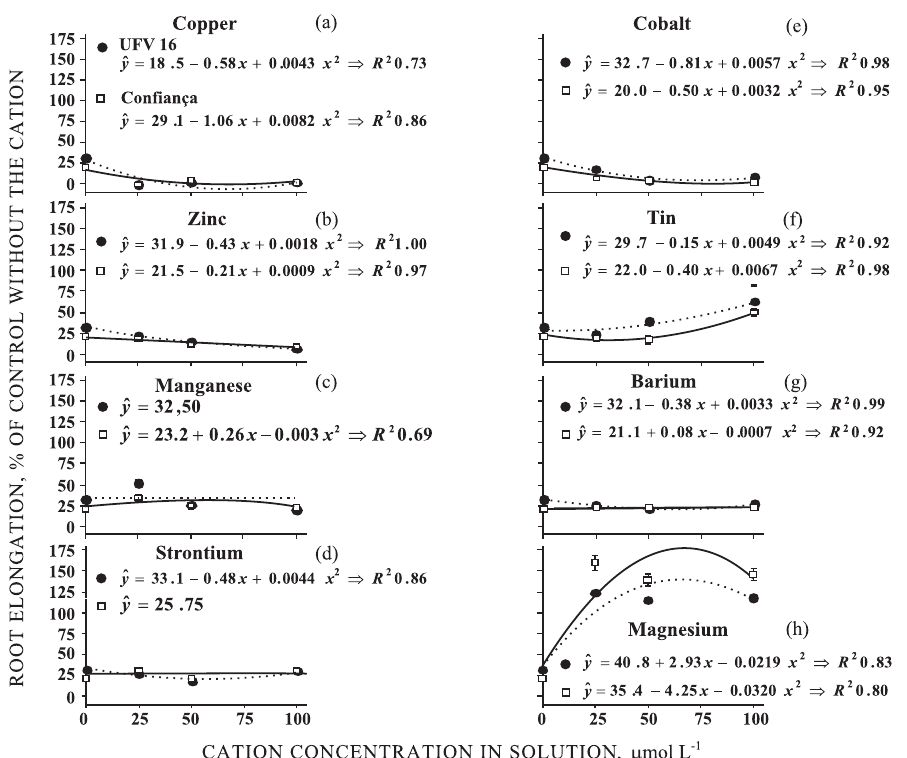
Figure 2. Relative root elongation of soybean cultivars UFV-16 and Confiança as a function of increasing doses of divalent cations in a CaCl 500 mmol L -1 (pH 4.5) basal solution, in the presence of 10 μ mol L -1 2 Al. Error bars represent standard error (n =